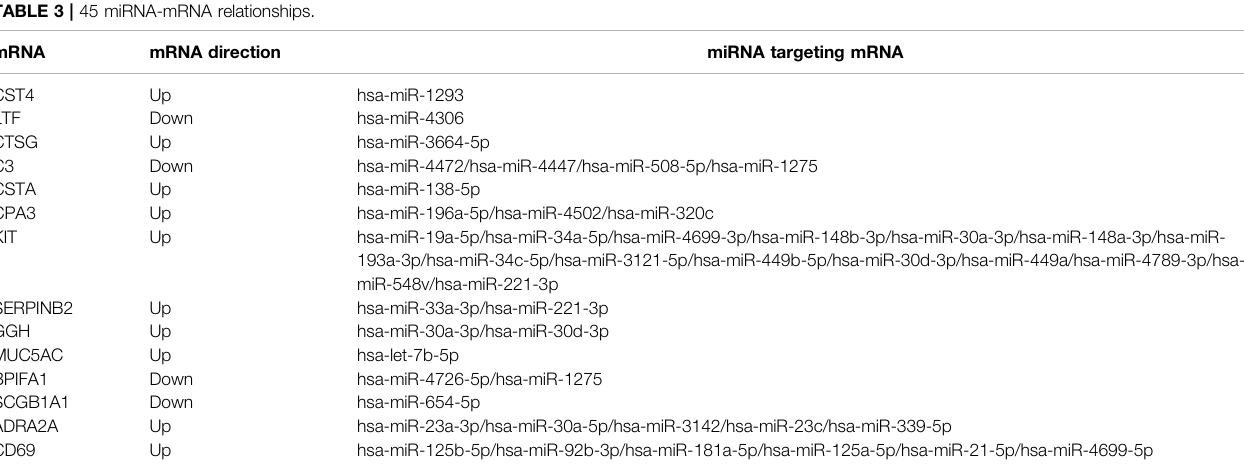
TABLE 3 | 45 miRNA-mRNA